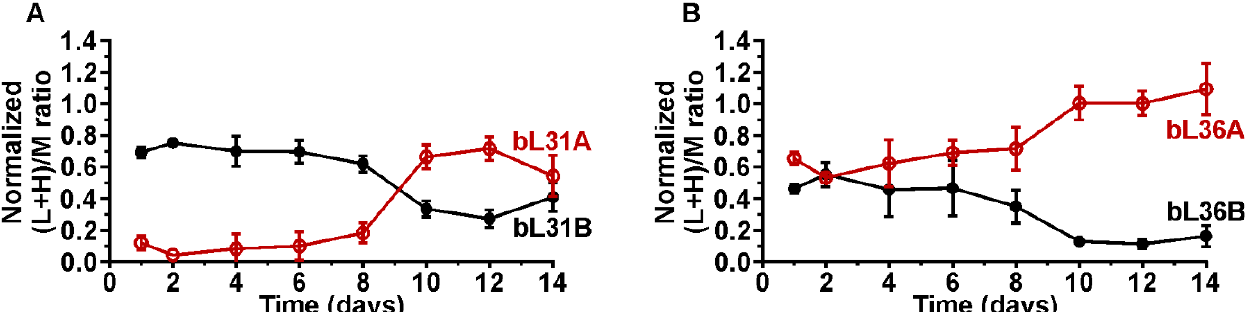
Figure 3. bL31 and bL36 paralogs in E. coli stationary phase ribosomes. E. coli batch culture was grown and samples were collected over the course of 14 days. 70S ribosomes were isolated and mixed in a 1:1 ratio with medium-heavy labeled reference 70S ribosomes for r-protein quantification using LC-MS/MS. The relative quantities of bL31A and bL36A (red, empty), and bL31B and bL36B (black, filled) are presented as the (L + H)/M ratio (L + H = sample; M = reference), and normalized against the average of (L + H)/M ratio of all 50S r-proteins and respective r-protein fraction in the reference ribosomes (see materials and methods). ( A ) Quantity of bL31A and bL31B in 70S ribosomes during 14 days of stationary phase. ( B ) Quantity of bL36A and bL36B in 70S ribosomes during 14 days of stationary phase. Values shown are the mean of three independent biological experiments with standard deviation (n = 3; mean ± SD).